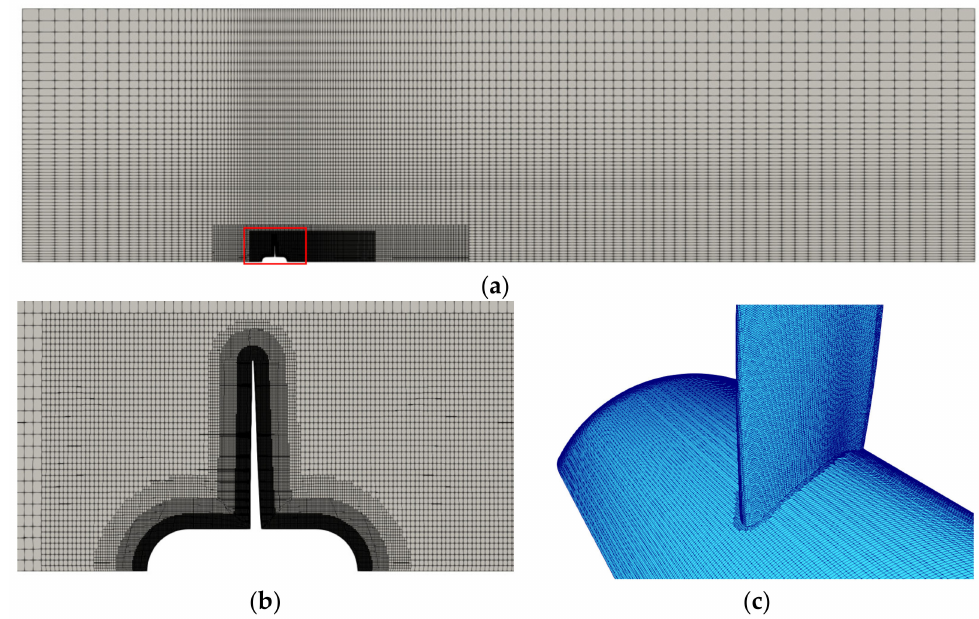
Figure 2. Typical medium mesh used for the RANS analysis simulations: ( a ) Longitudinal section along xz plane y = 0; ( b ) detail of longitudinal section on turbine area; ( c ) detail of surface mesh at blade